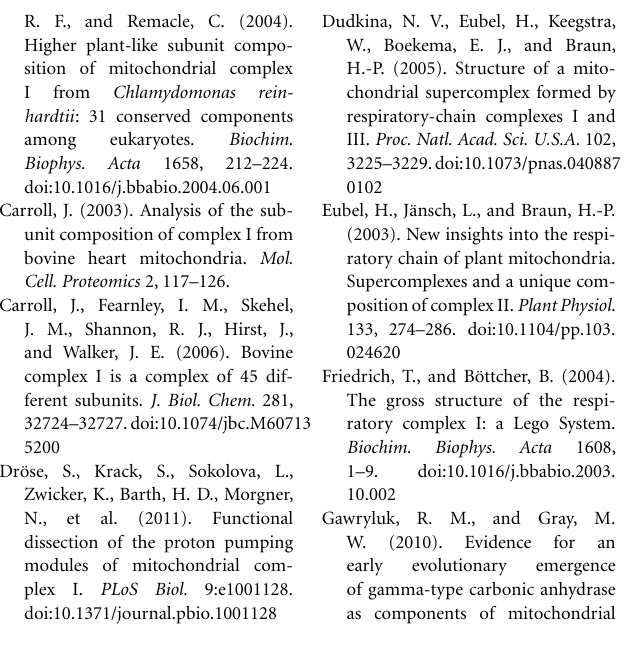
FIGURE 3 | GelMap of complex I as resolved by 3D BN/SDS/SDS- PAGE (http://www.gelmap.de/arabidopsis-3d-complex-i/) . Upon hovering with the cursor over a spot, a tooltip including information on all included proteins is opened. In the example given on the figure, the indicated spot includes the CAL2 protein and two isoforms of theTYKY